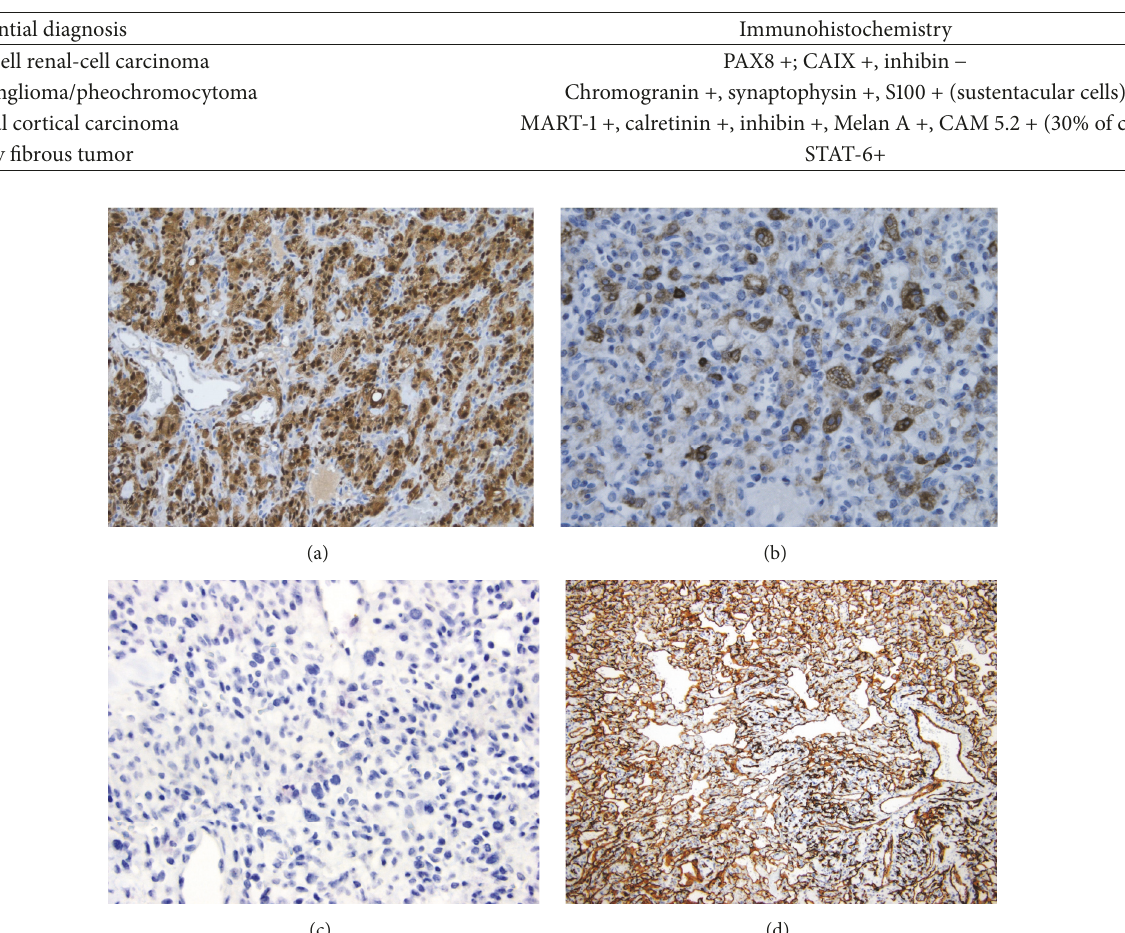
Table 1: Hemangioblastoma. Differential diagnosis. (+) positive; ( − ) negative.